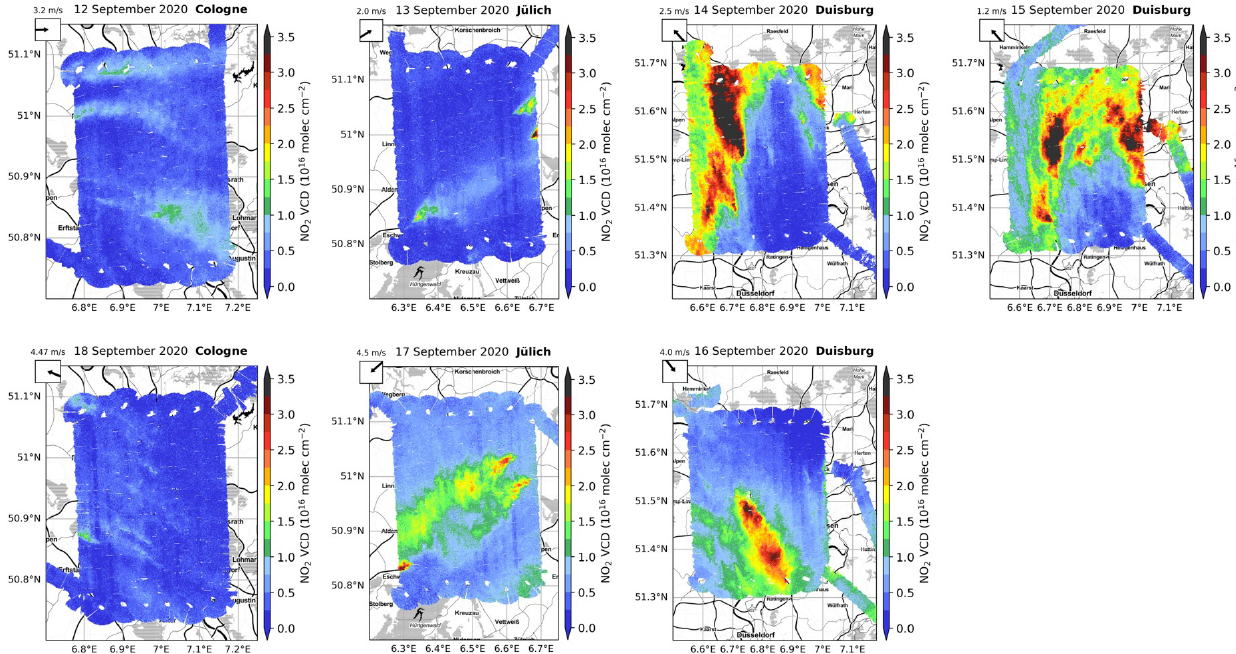
Figure 4. Maps of VCD NO 2 from AirMAP flights from 12 to 18 September 2020. Two flights in the research flight area around Cologne (left column), two flights in the flight area around Jülich (second column), and three flights in the flight area around Duisburg (third and fourth column). The mean wind direction and speed in the flight area, determined from ERA5 10m wind data for the middle of the flight, are given in the top left